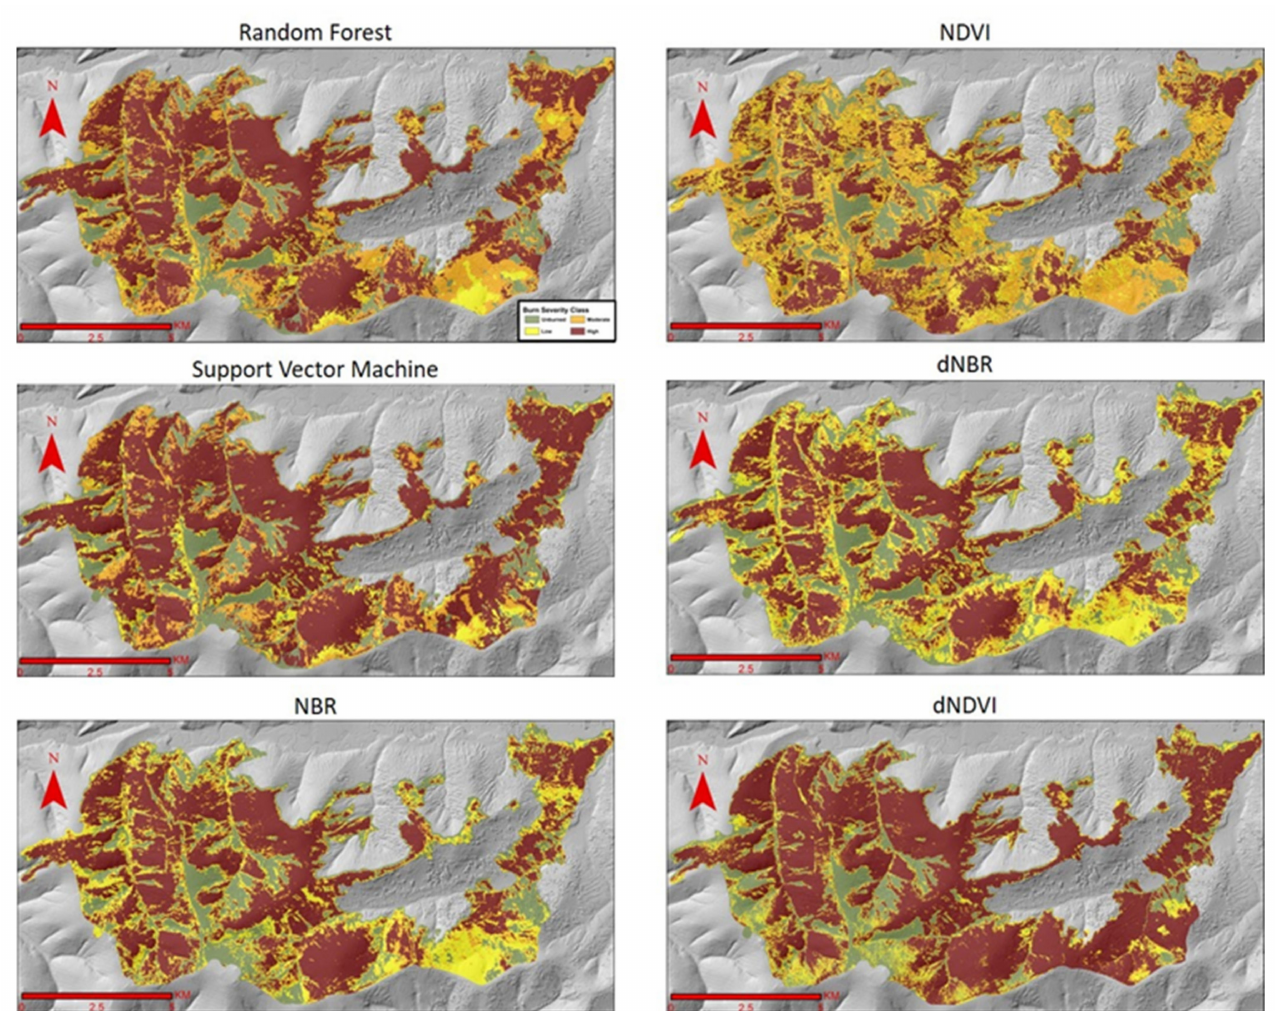
Figure 7. Comparison of the Shovel Creek burn severity map products.